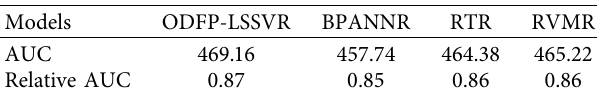
Figure 11: Boxplots of prediction model performances. Table 4: Model performance evaluation based on regression error characteristic curves.